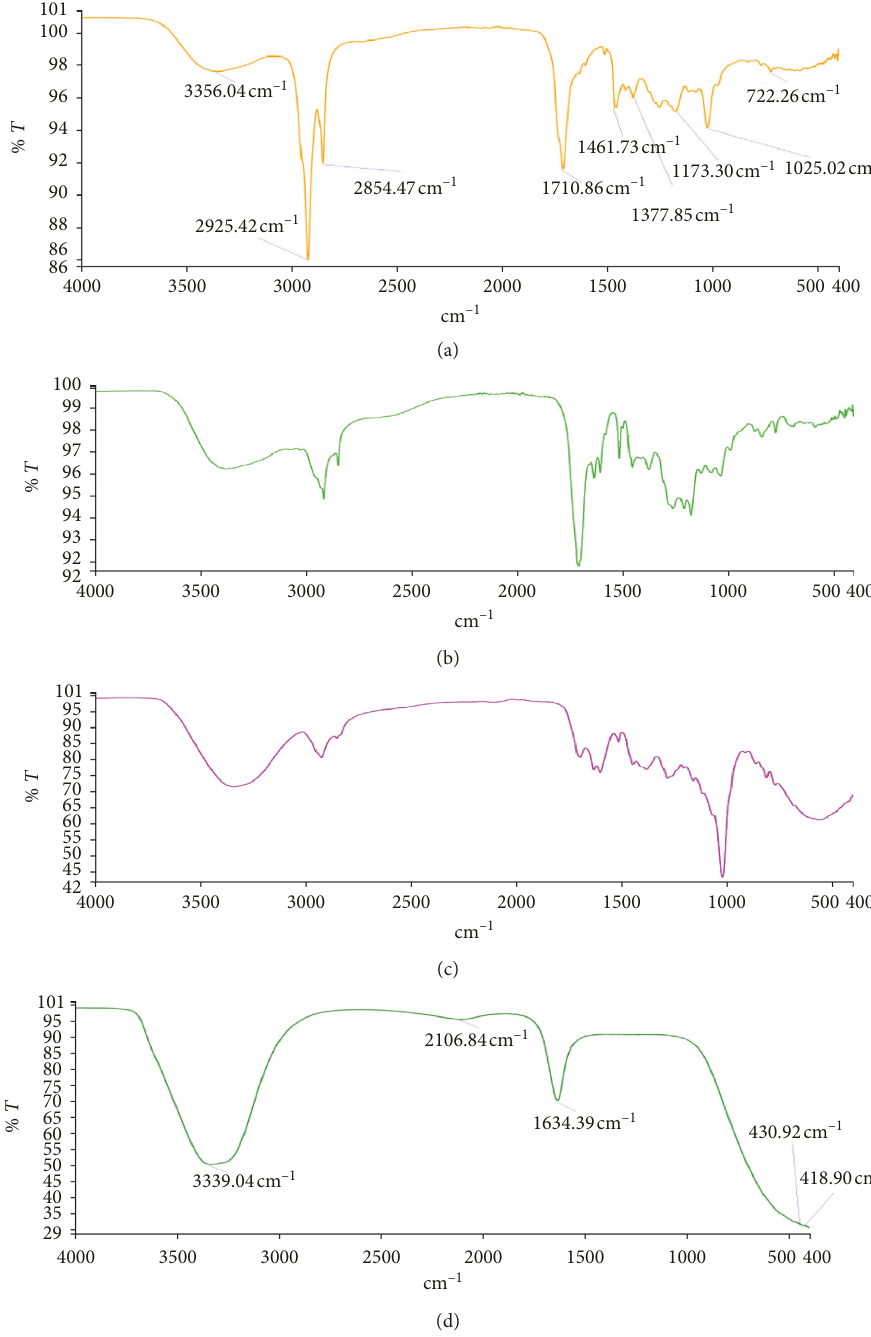
Figure 1: FTIR spectrum of petroleum ether (a), ethyl acetate (b), methanolic fraction (c), and hydro fraction (d) of D. erecta leaf